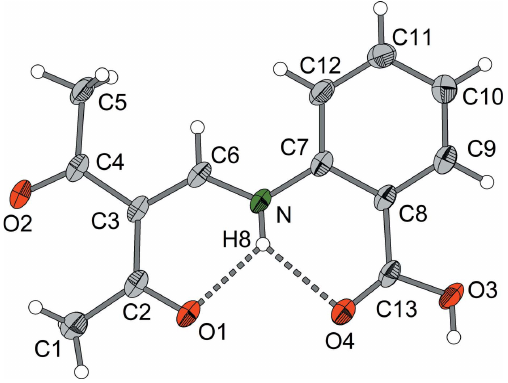
Figure 3 Molecular structure of enamine 3 showing the labelling scheme. The hydrogen bond is shown as a dashed line; displacement ellipsoids are drawn at the 50% probability level.